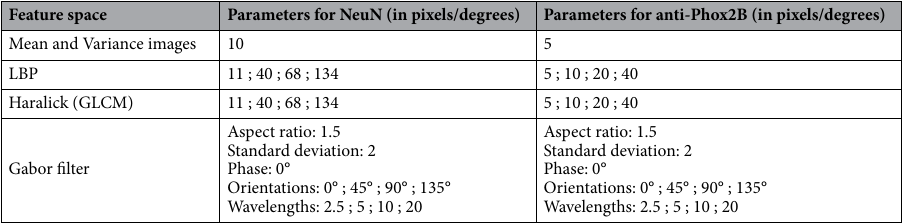
Table 1. Sum up of initial feature vector parameters for NeuN and anti-Phox2B